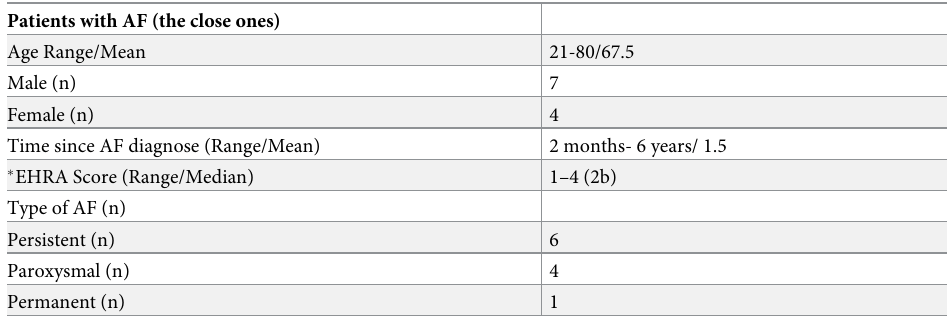
Table 2. Characteristics of AF burden in the close one with AF (the patients). Patients with AF (the close ones)